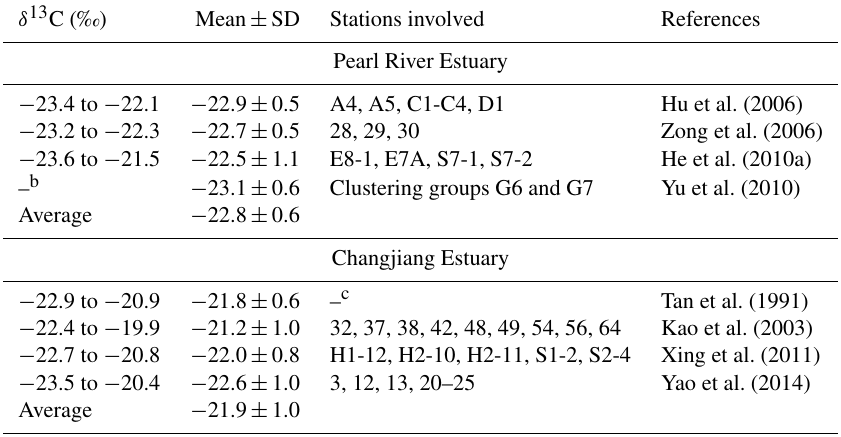
Table 2. Comparison of δ 13 C values in surface sediments within the hypoxic zone a between the PRE and CJE.